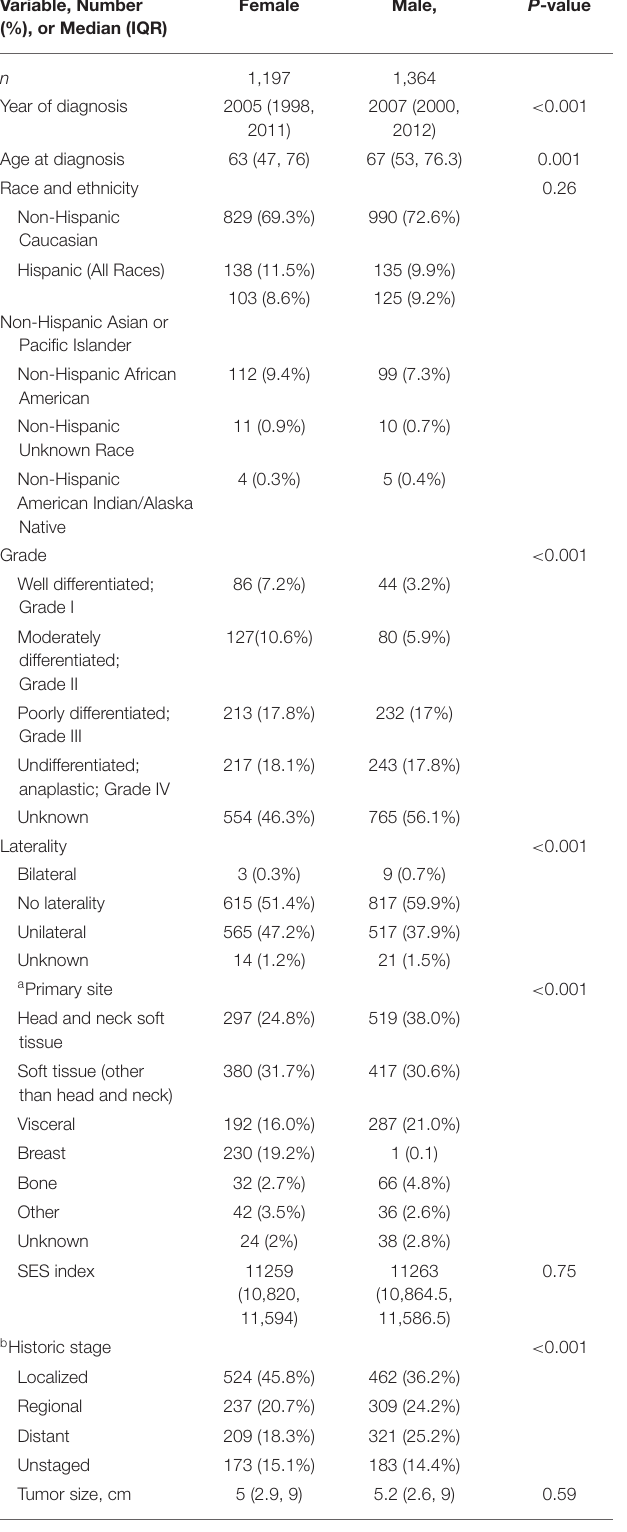
TABLE 4 | Comparison of women vs. men in patients with primary angiosarcoma in SEER database, 1975–2016. Variable, Number (%), or Median